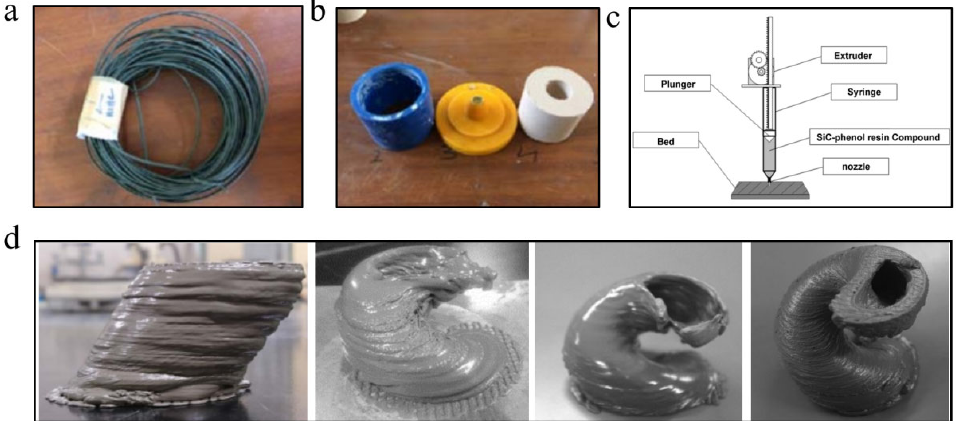
Fig. 17 FDM of SiC ceramic: (a) Filament wires, (b) flexible molds. Reproduced with permission from Ref. [63], ©